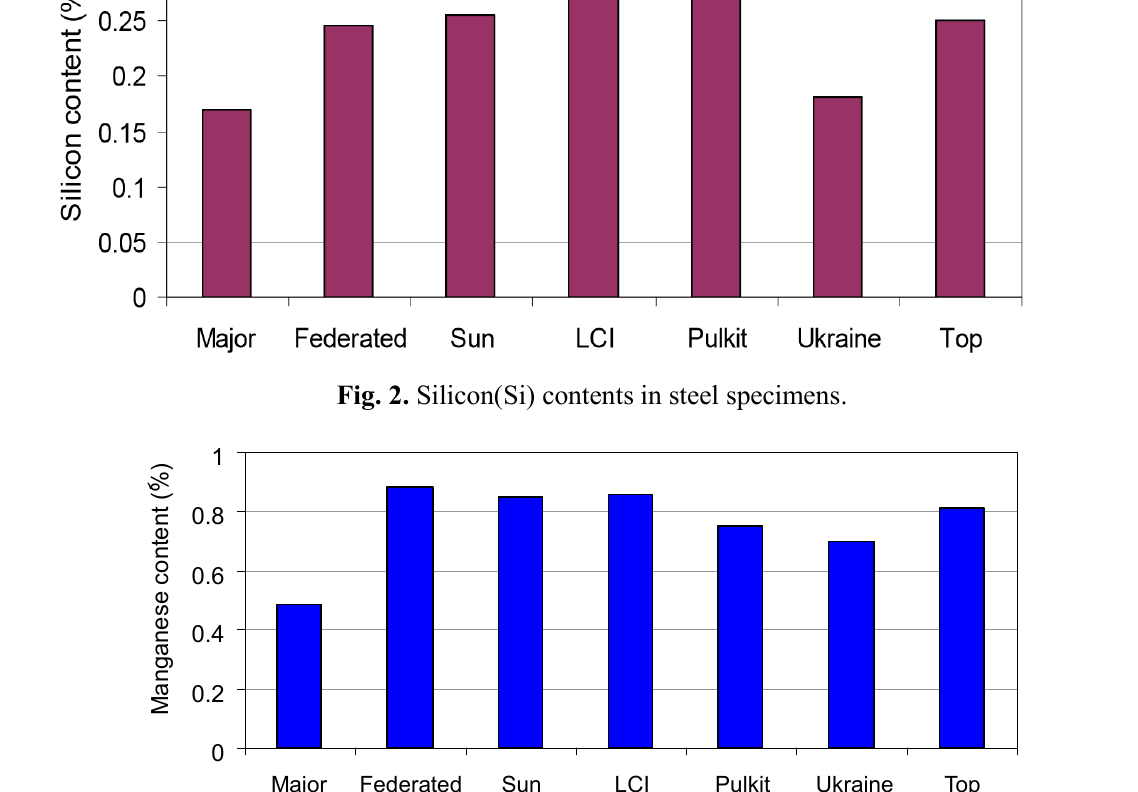
Fig. 1. Carbon(C) contents in steel specimens.